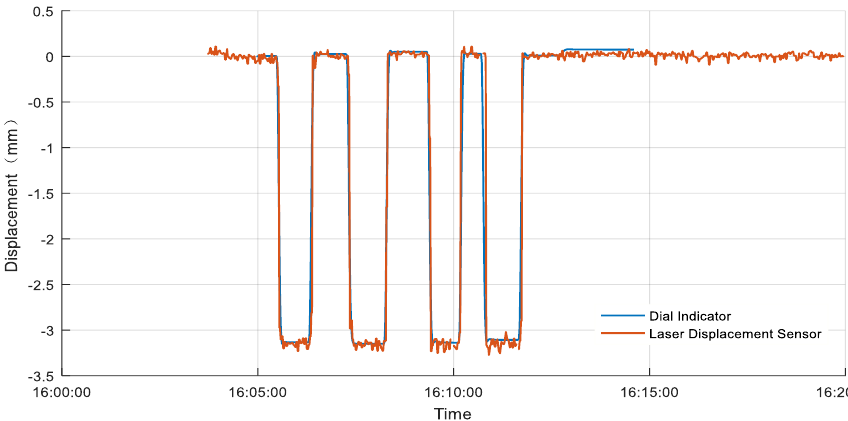
Figure 10. Displacement curve of the whole process from loading to unloading.